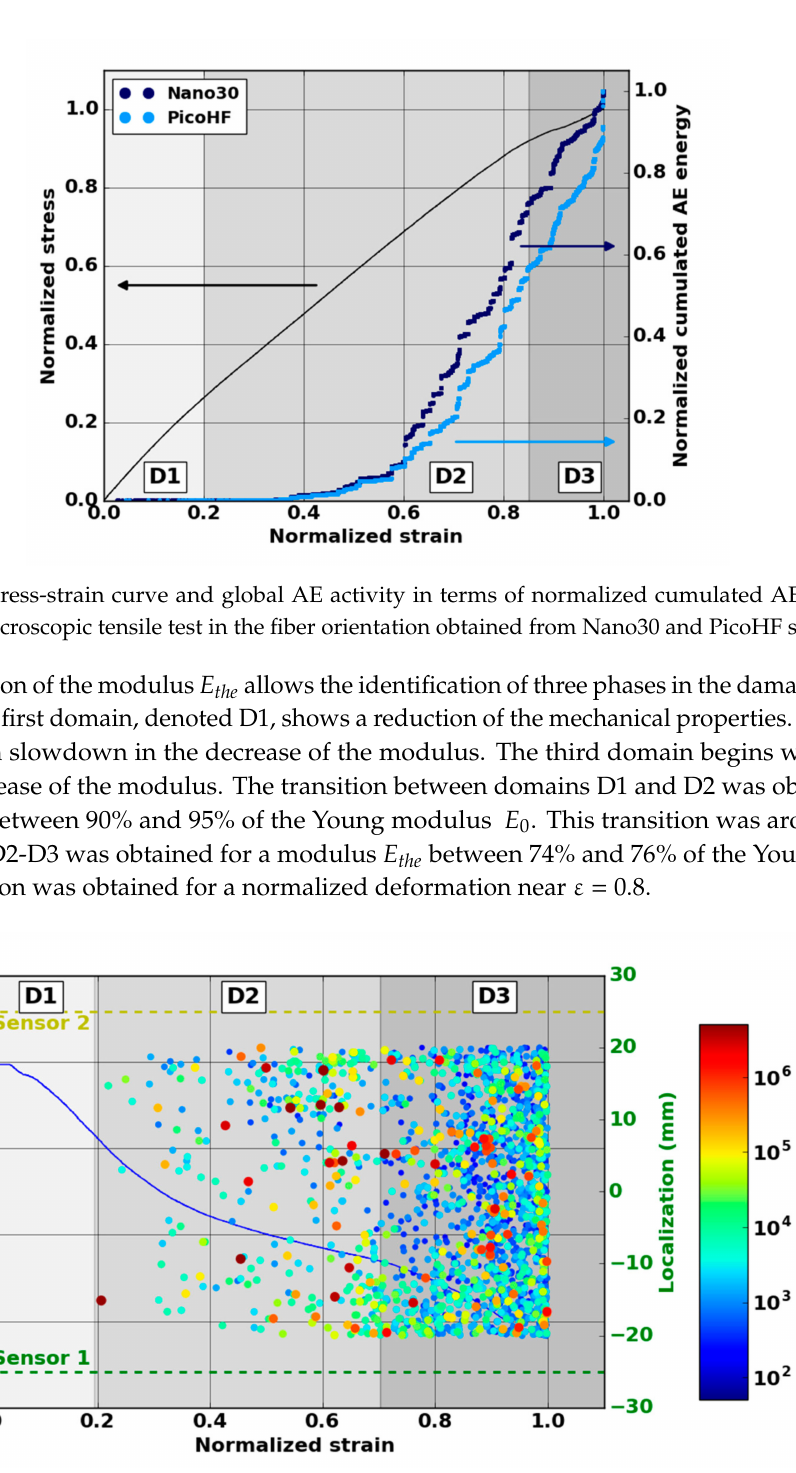
Figure 10. Evolution of the normalized modulus and the location of Nano30 AE signals versus strain during the macroscopic tensile test in the fiber orientation. (The size and the color of the dot are linked with the